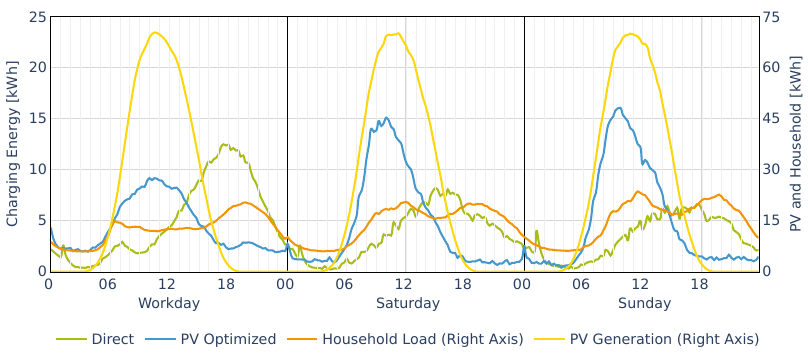
Figure 11. Aggregated average for EV charging energy and corrensponding PV generation and household load on different type days: “direct charging” and “PV optimized